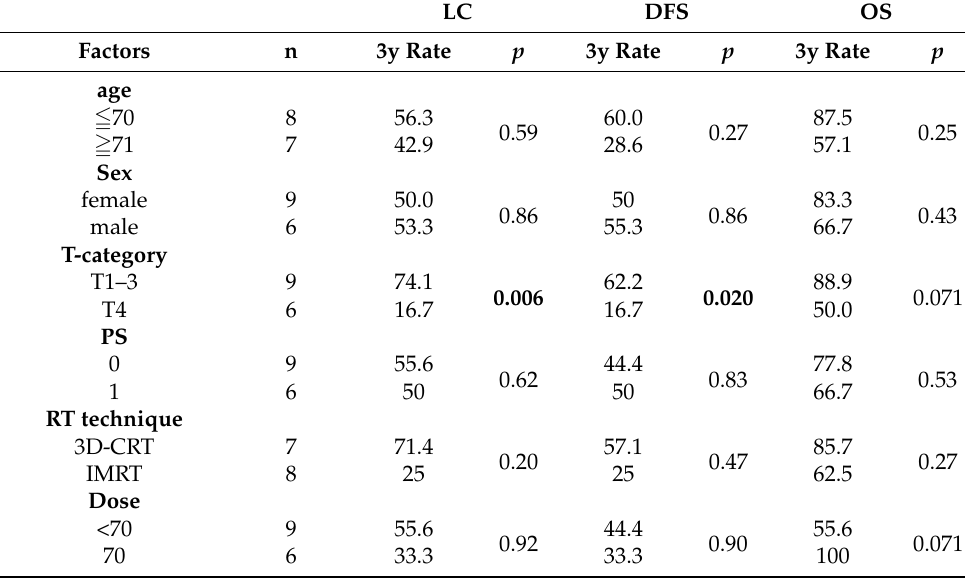
Table 3. Treatment outcome according to the clinical and treatment factors.